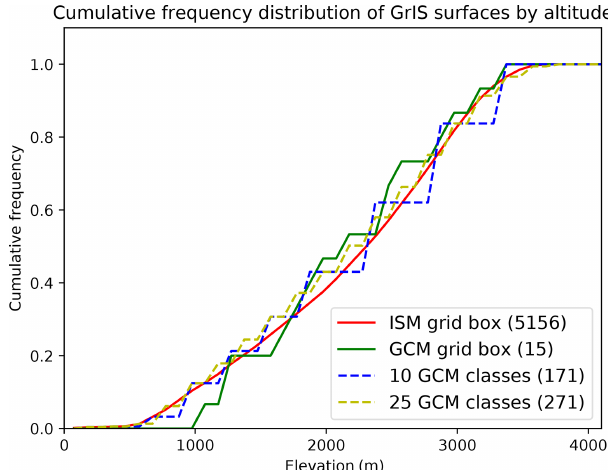
Figure 1. The distribution and number of individual surfaces modelled on the Greenland ice sheet on different grids. Red: a 20km ice sheet model; green: normal FAMOUS grid boxes; blue dashed: FAMOUS-ice with 10 sub-grid-scale elevation classes; yel- low dashed: FAMOUS-ice with 25 elevation classes. The total num- ber of surfaces modelled for Greenland in each representation is given in